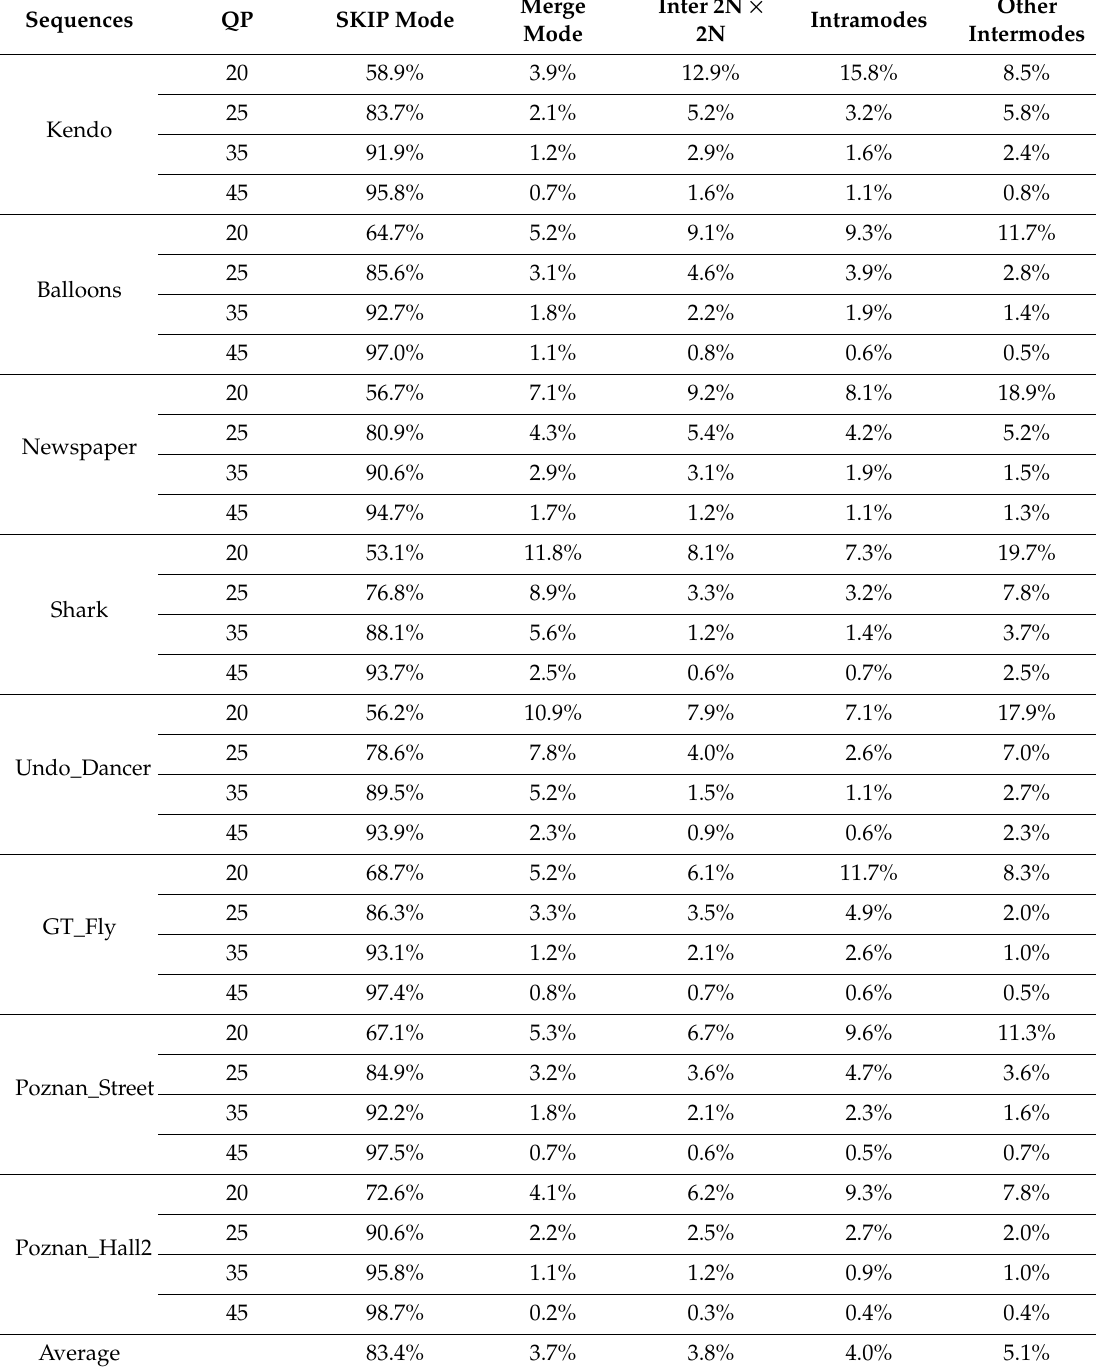
Table 1. Intermode distribution in depth